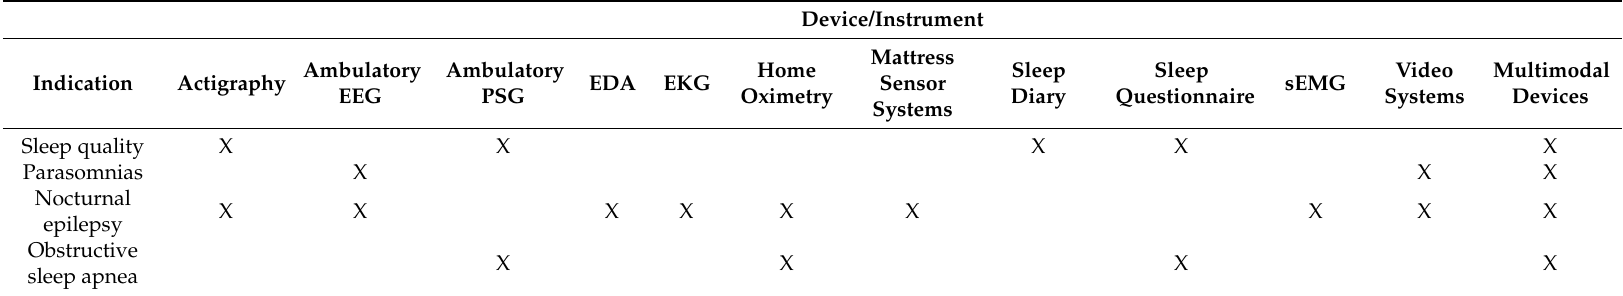
Table 1. Suggestions for monitoring of sleep and related indications with portable devices (choices are not exclusive, and may vary based on available resources and physician